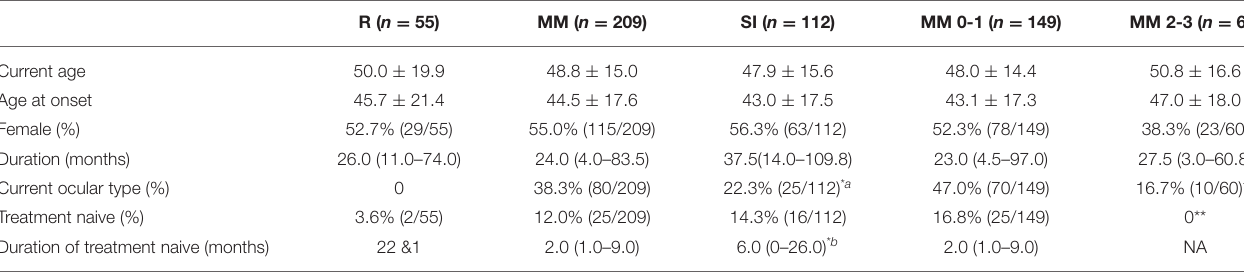
TABLE 2 | Generalized characteristics of patients belonging to each PIS category as the baseline.